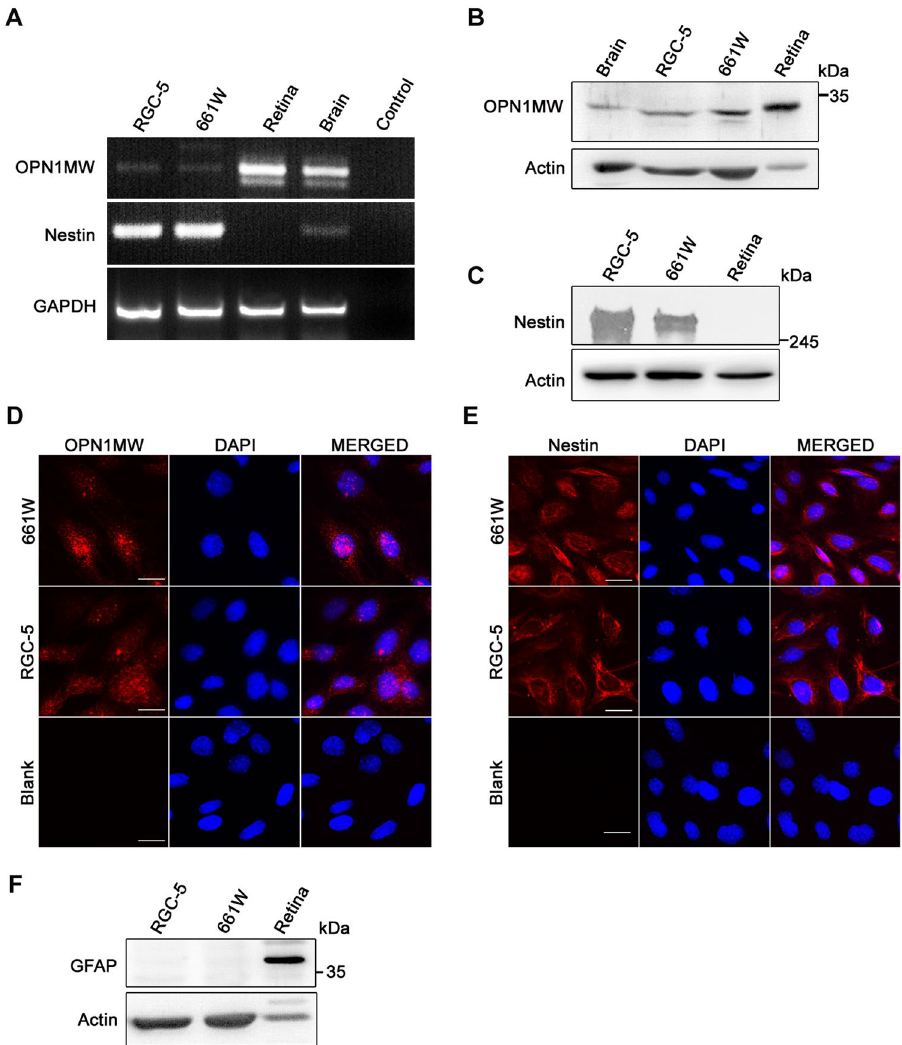
Figure 3. Expression of a cone-specific marker and nestin in 661W cells. ( A ) Semi quantitative PCR analysis for mRNA expression of cone-specific marker OPN1MW and neuronal precursor marker nestin. ( B , C ) Western blot analysis of 661W and RGC-5 cells showing the expression of OPN1MW and nestin, respectively. ( D , E ) Immunostaining of 661W and RGC-5 cells for OPN1MW and nestin respectively. Scale bar, 10 µ m. ( F ) Expression analysis of GFAP, a glial cell specific marker by western